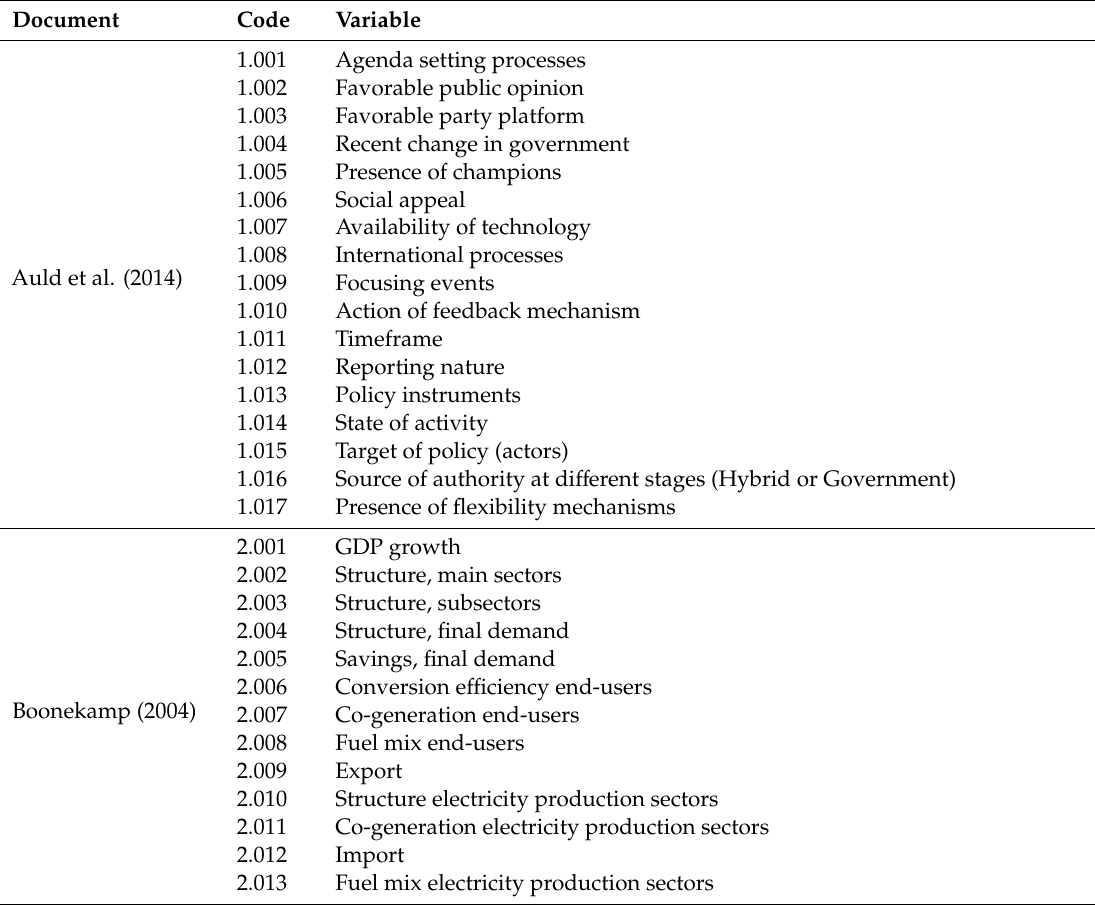
Table A1. Full list of variables identified in the systematic literature review process and respective